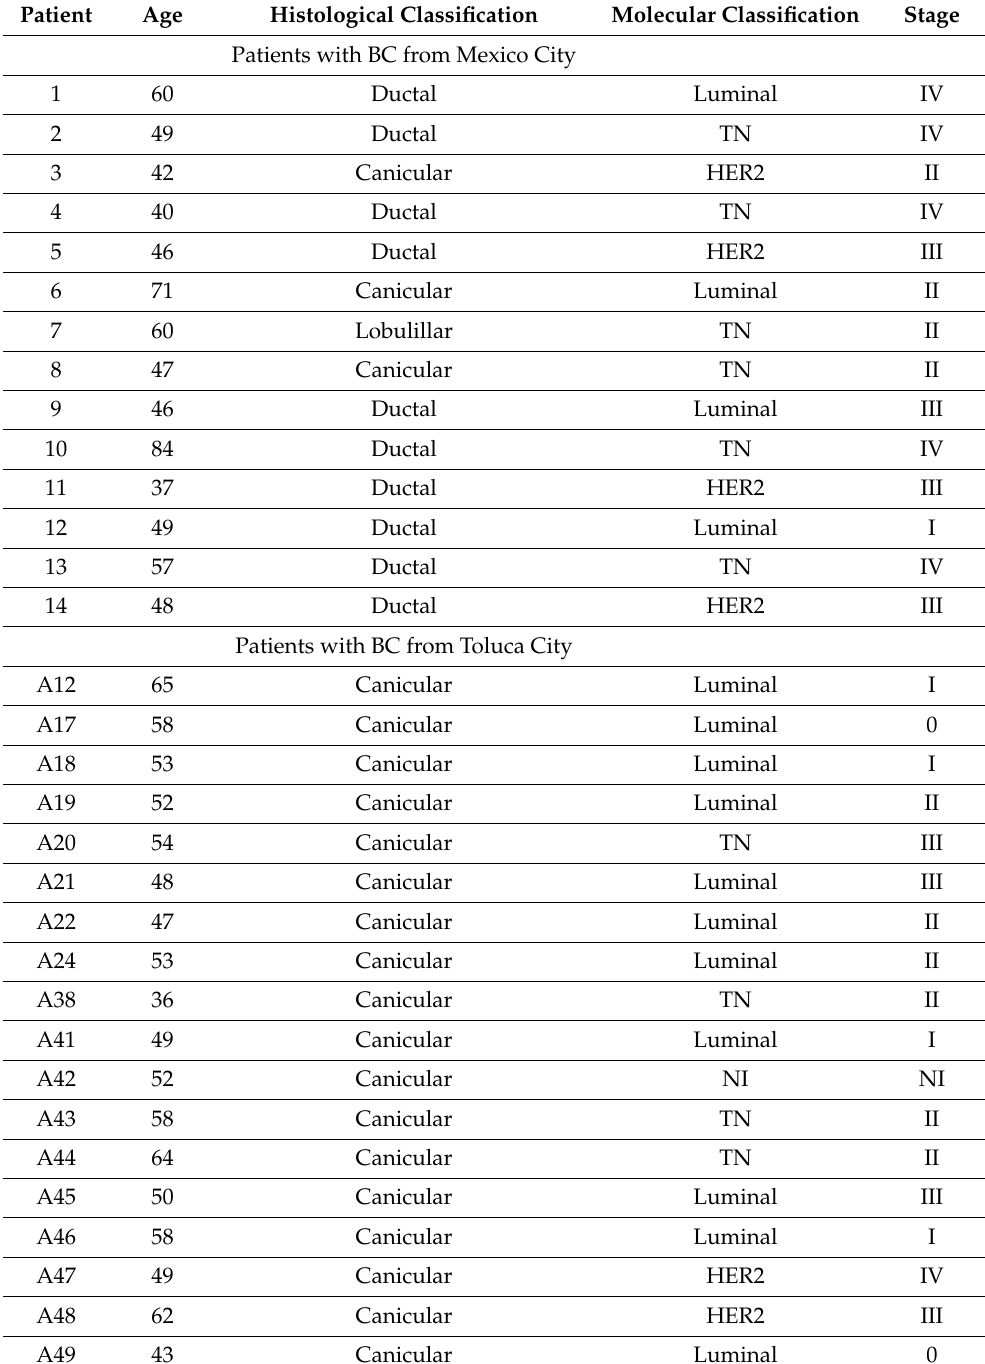
Table 1. Clinicopathological characteristics of patients with BC and survivors of this disease. Patient Age Histological Classification Molecular Classification Stage Patients with BC from Mexico City